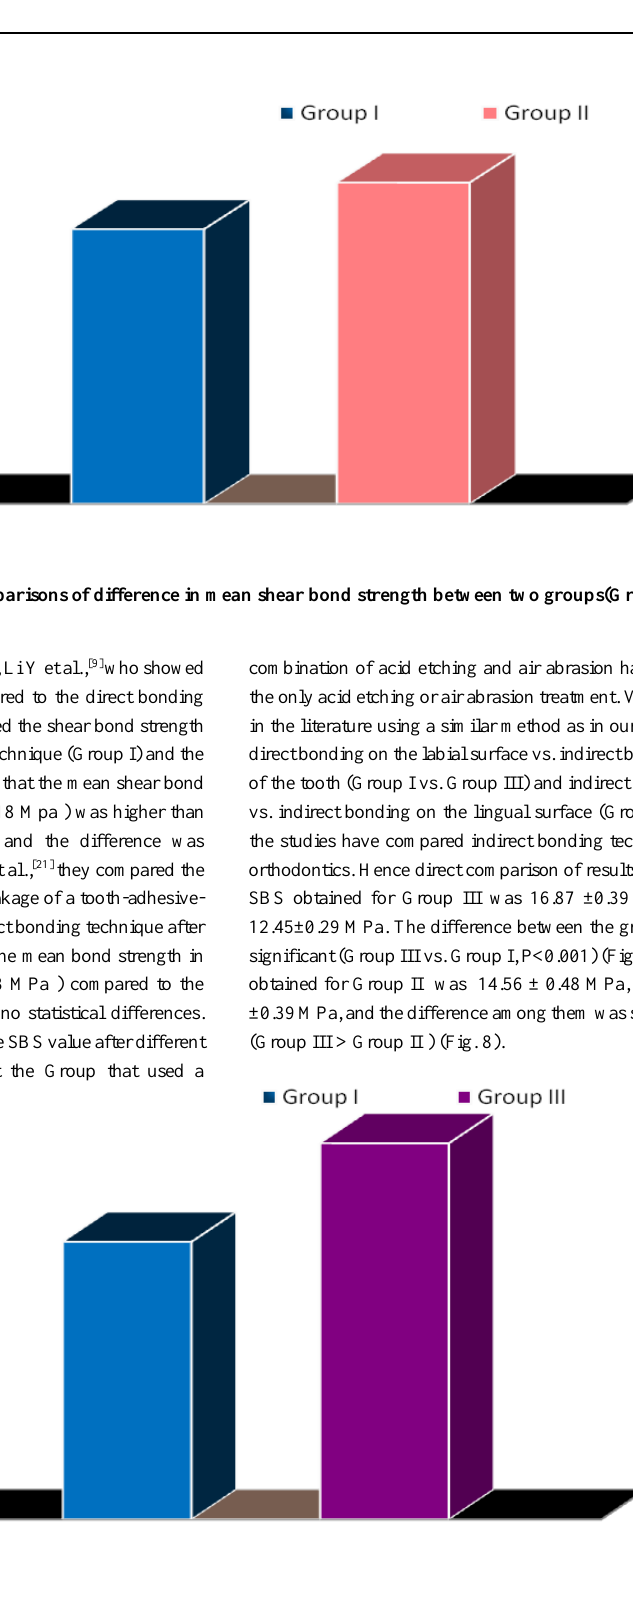
Fig. 7. Bar diagram depicting comparisons of difference in mean shear bond strength between two groups (Group I and